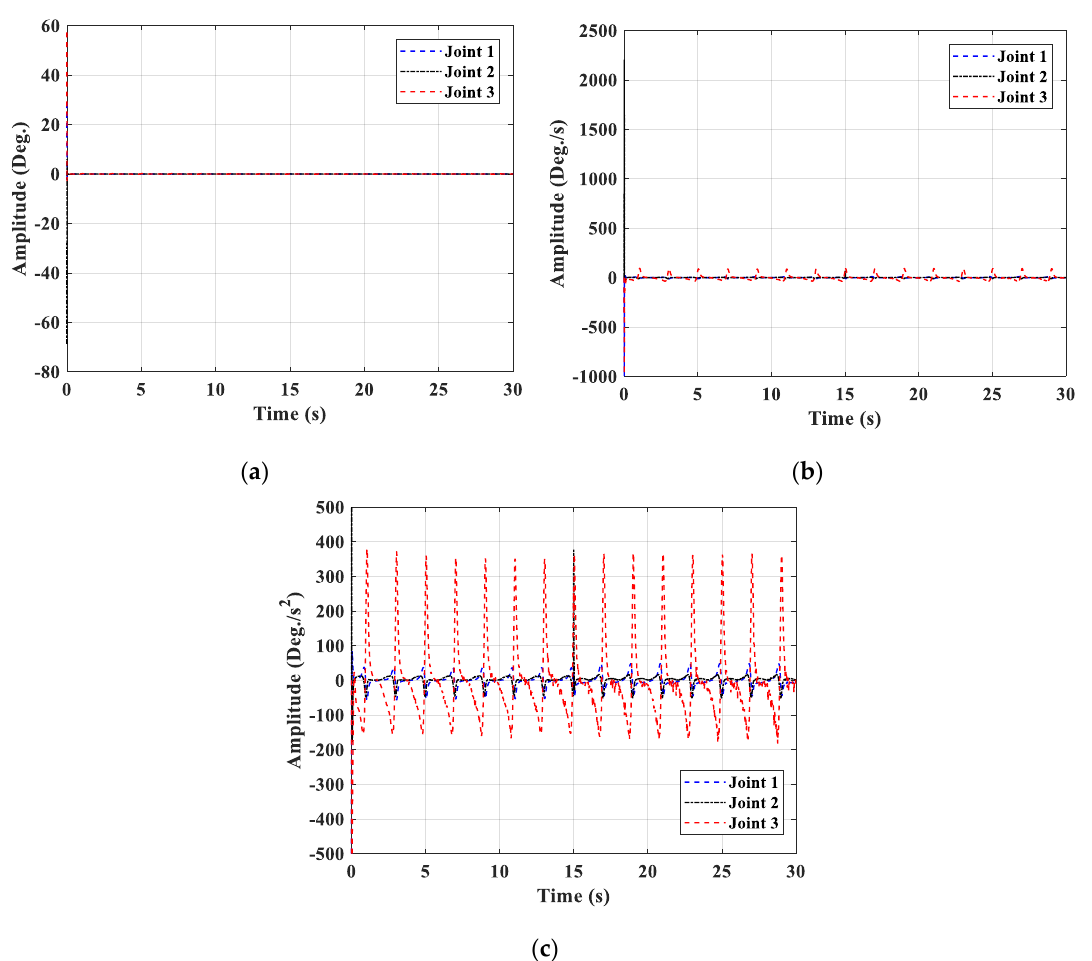
Figure 11. Lumped disturbance response of the planar manipulator at 0.5 Hz: ( a ) lumped disturbance and ( b ) estimated lumped disturbance.